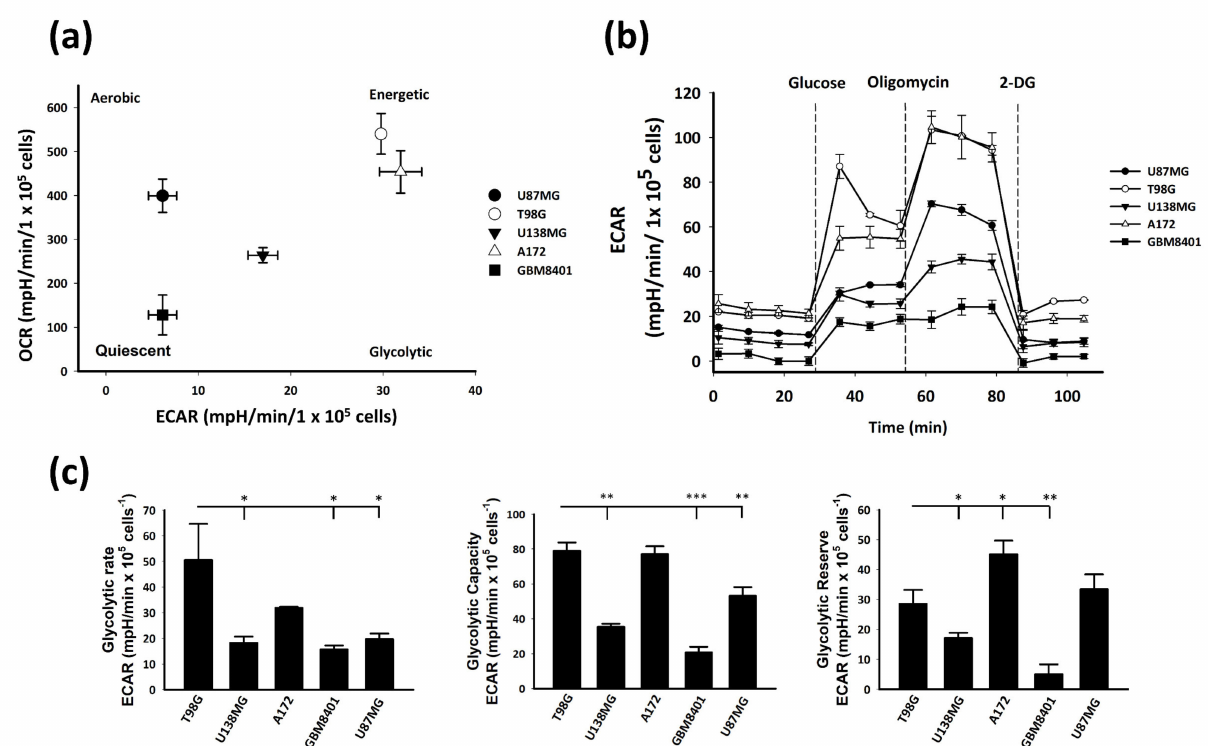
Figure 3. Bioenergetic profiles of five well-known GBM cell lines. ( a ) Basal extracellular acidification rate (ECAR) and oxygen consumption rate (OCR) levels provide a snapshot of the bioenergetics profile of well-known GBM cell lines U87MG, T98G, U138MG, A172, and GBM8401. Values were measured and normalized to cell numbers by using the Seahorse Extracellular Flux (XF) Analyzer. ( b ) Real-time measurement of the ECAR as the glycolysis rate. Glucose (10 mM), oligomycin (1 µ M) and 2-DG (50 mM) were injected at the indicated times. Values are expressed as mean ± SD ( n = 3). ( c ) The glycolytic rate, glycolytic capacity, and glycolytic reserve were analyzed using standard methods. Values are expressed as the mean ± SD ( n = 3). * p < 0.05, ** p < 0.01, *** p < 0.001 relative to T98G